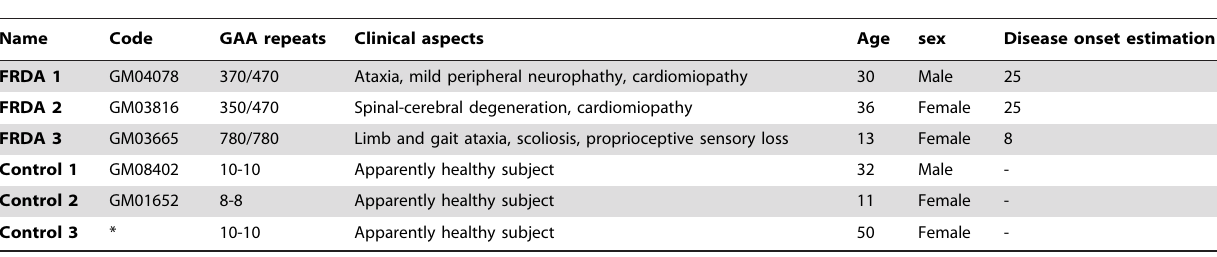
Table 1. Characterization and identification of FRDA and control cell